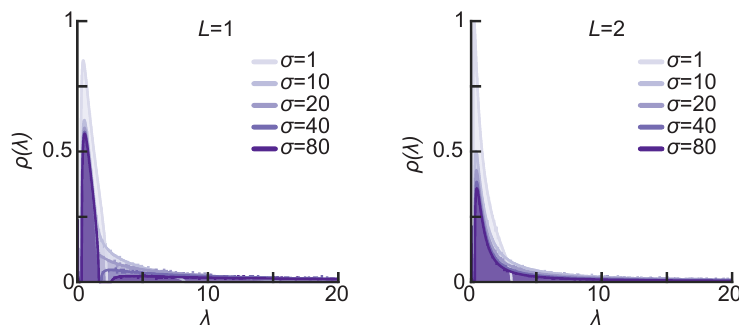
= ··· = α = α = 4. The correlation struc- L 1 ( z ) = ··· = M ( z ) given by (37) with Σ L 1 = 2048. Importantly, 0